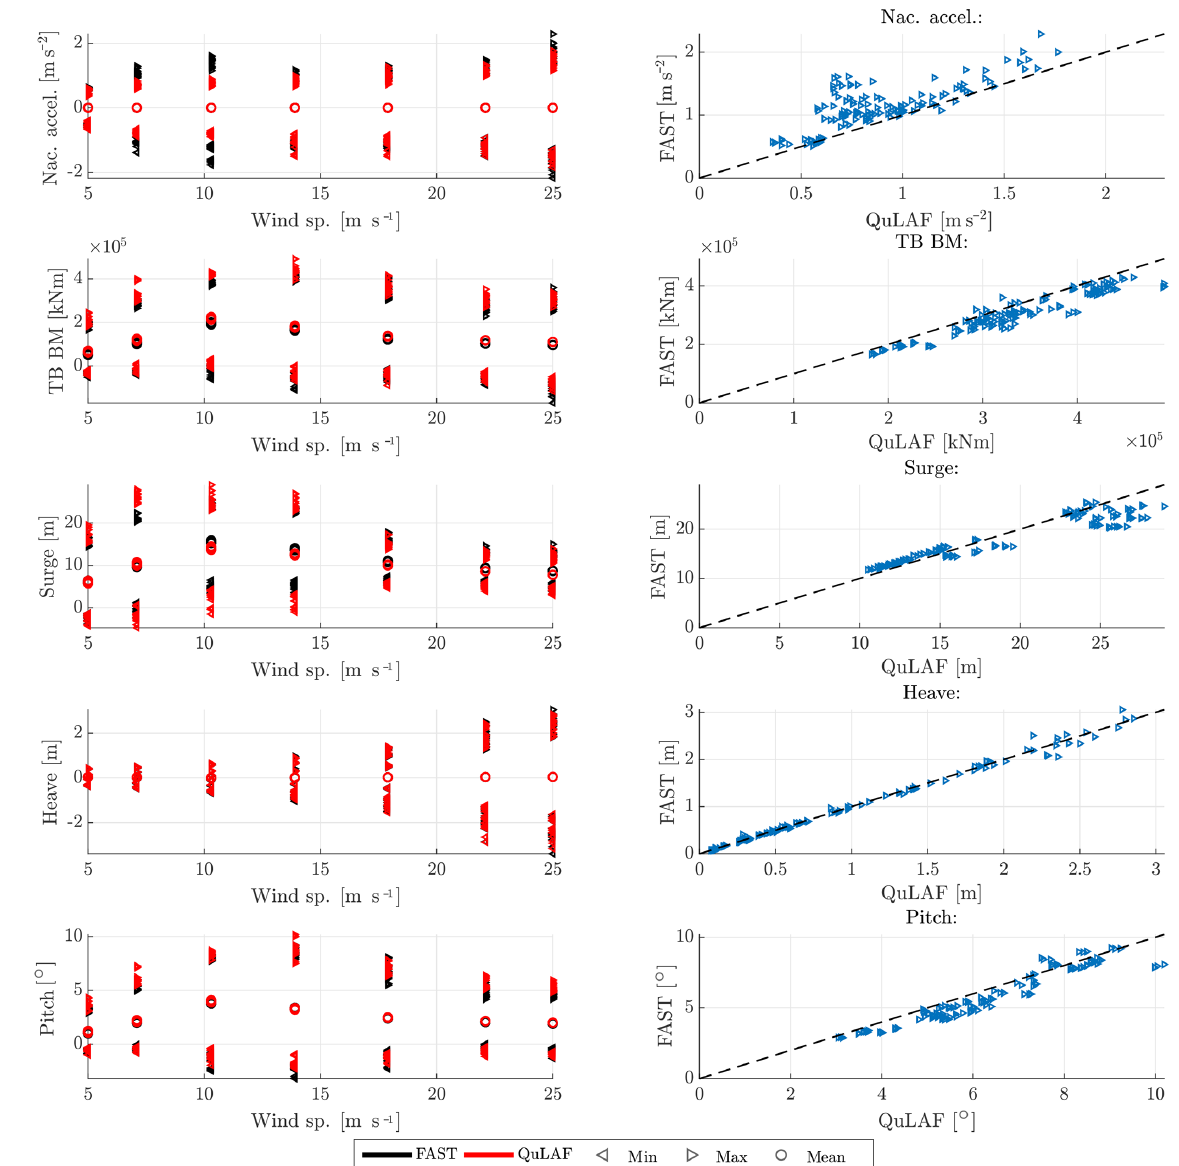
Figure 4. Response to DLC 1.3 for FAST and QuLAF. Left: min., max. and mean values for every realization as a function of wind speed. Right: maximum values for FAST as a function of the corresponding maximum values in